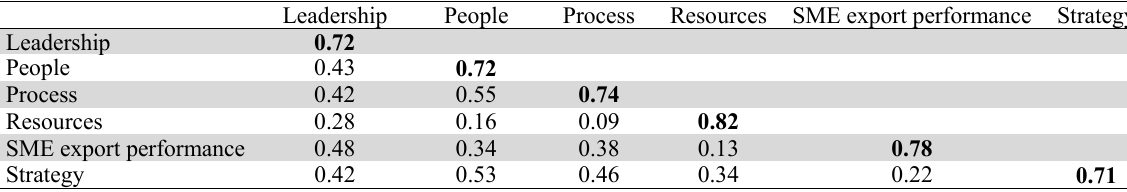
Fornell-Larcker Criterion Leadership People Process Resources SME export performance Strategy